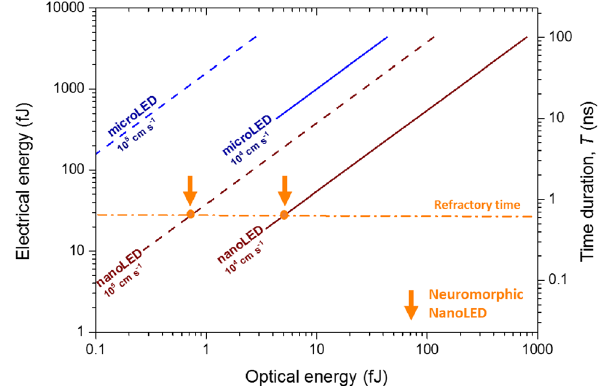
Figure 6: Electrical energy as a function of the optical energy per bit mapped for received time duration of the bits ranging from 100 ns to 100ps.Thediagonallinesarethevaluesforthemicro-andnanoLEDs in a non-spiking regime, that is, in a standard current modulation scenario assuming operation in the vicinity of the valley voltage at 1.735 V. The dashed lines represent the case of a large surface recombination of 10 5 cm s − 1 while the solid lines represent the best case of a low surface recombination, 10 4 cm s − 1 . The dashed-dot horizontal line is the refractory time of the neuromorphic nanoLED, τ ref = 650 ps. The dashed-dot horizontal orange line intersecting the diagonal traces indicates the refractory time and gives the electrical/optical energy per spike (indicated by the vertical orange arrows) of the neuromorphic nanoLED assuming continuous fi ring of spikes and operation in the vicinity of the valley